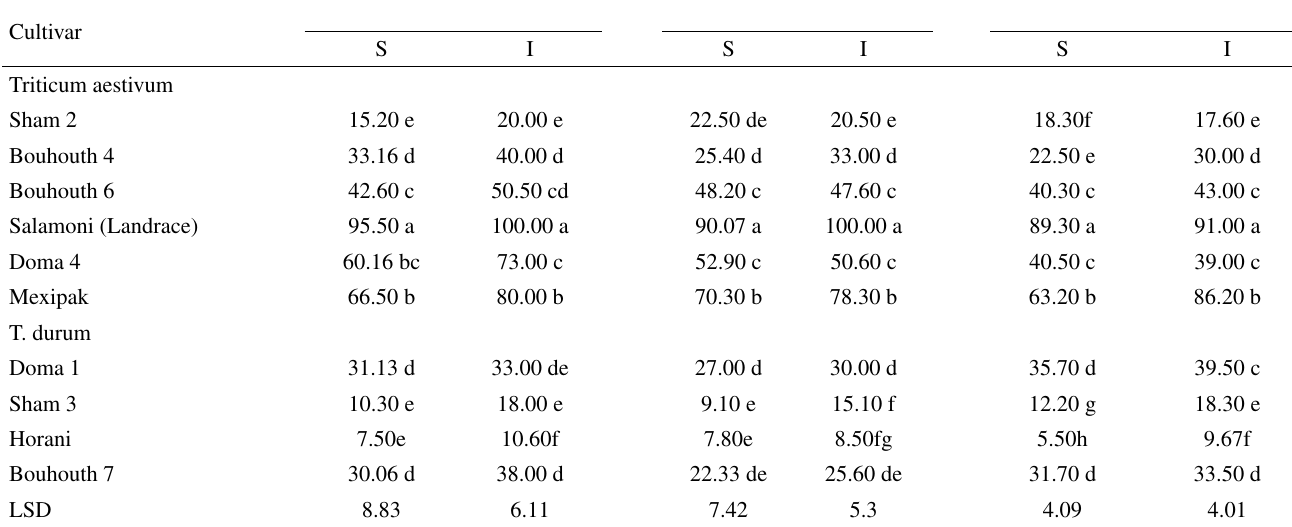
Values followed by different letters columns are significantly different at P = 0.001 according to Newman-keuls test. LSD: Least Significant Dif- ference at P<0.05.